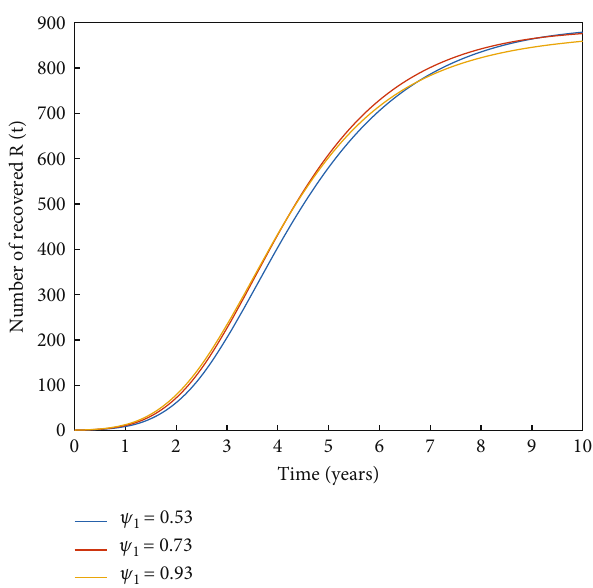
Figure 24: Transformation of infected individuals for transmission rate γ 1 with various values.